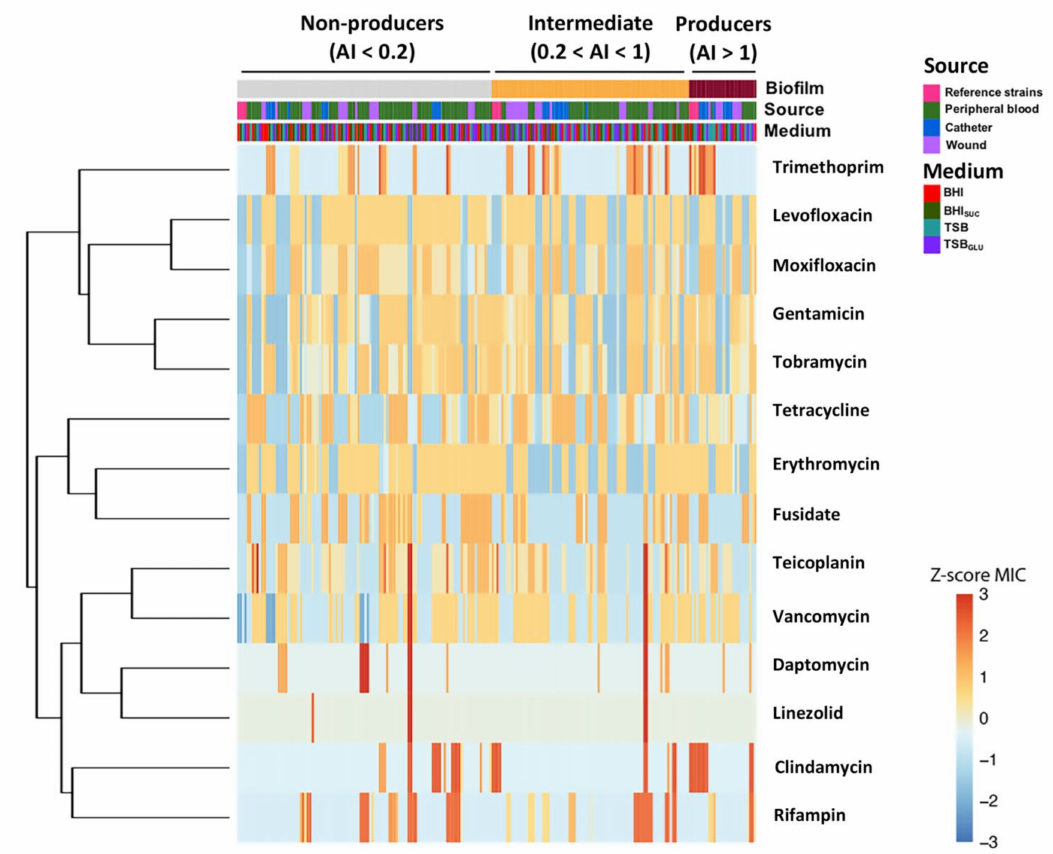
Figure 2. Heatmap of the antibiotic resistance profile of the S. epidermidis clinical isolates. S. epidermidis strains, isolated from the peripheral blood, catheters, or wounds of different patients and grown in different culture media, were grouped by their biofilm formation